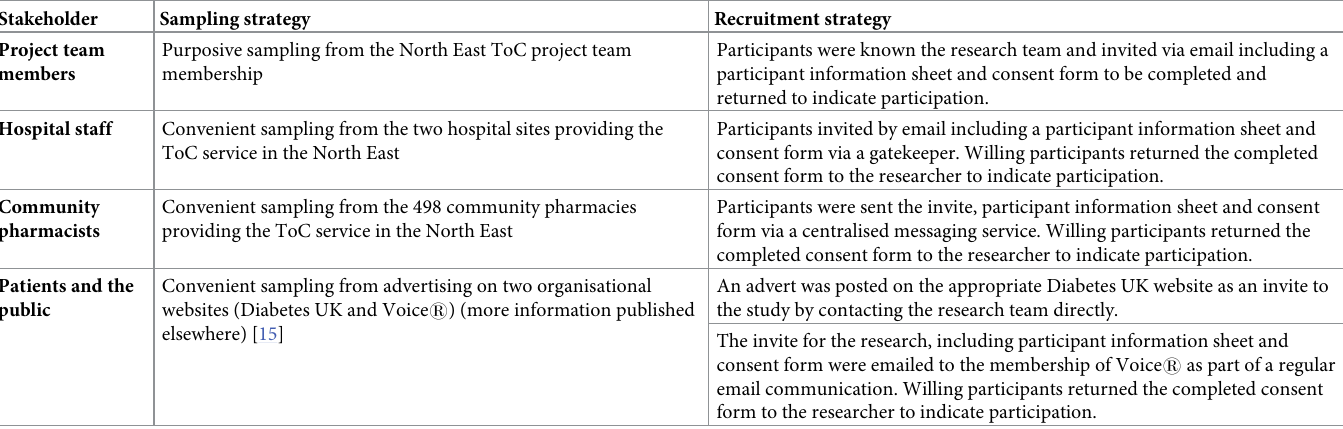
Table 2. The sampling and recruitment strategies for stakeholders